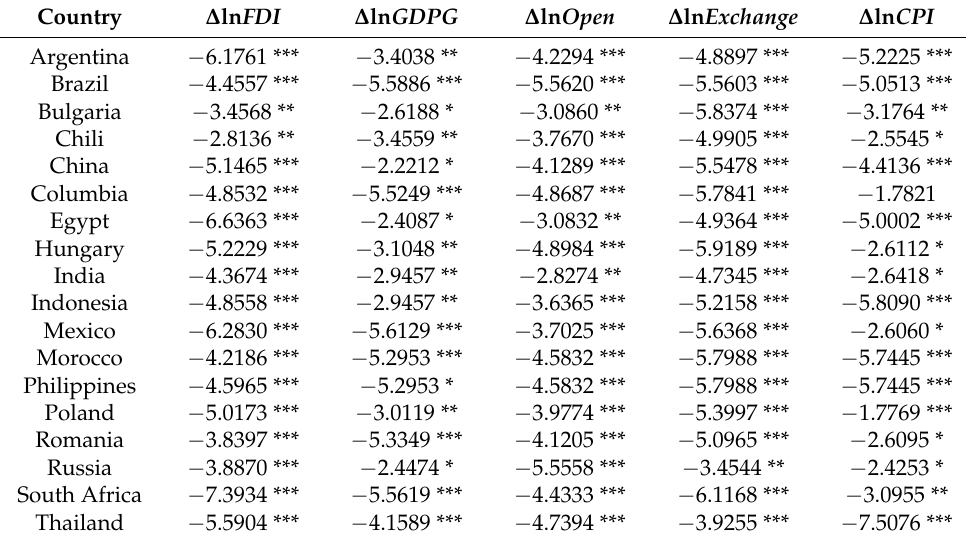
Table 3. Unit root test.